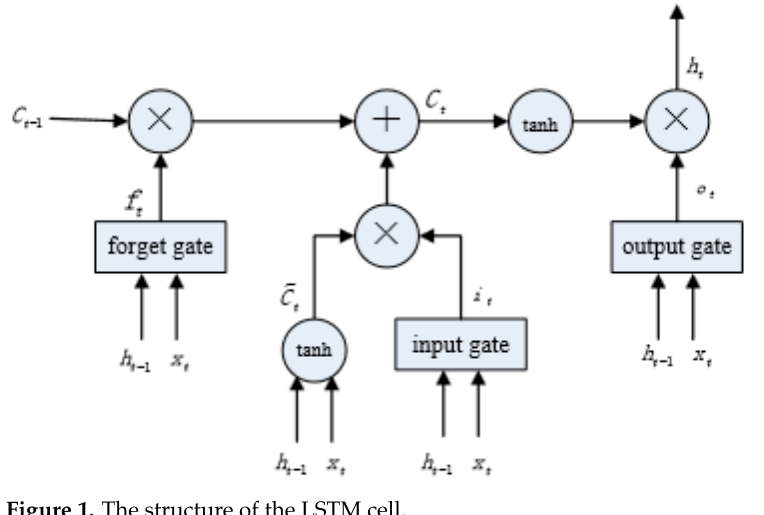
Figure 1. The structure of the LSTM cell.